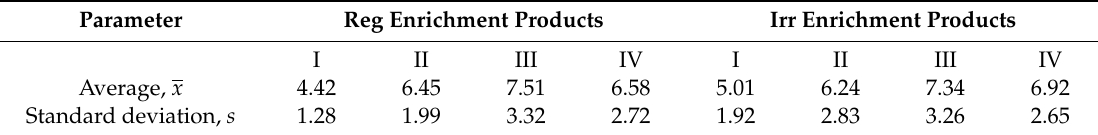
Figure 17. Dust generation for irregular particles—feed material 𝑥̅ = 4.46, s = 1.30. Table 1. Values of dust generation [mg / m 3 ] for individual enrichment